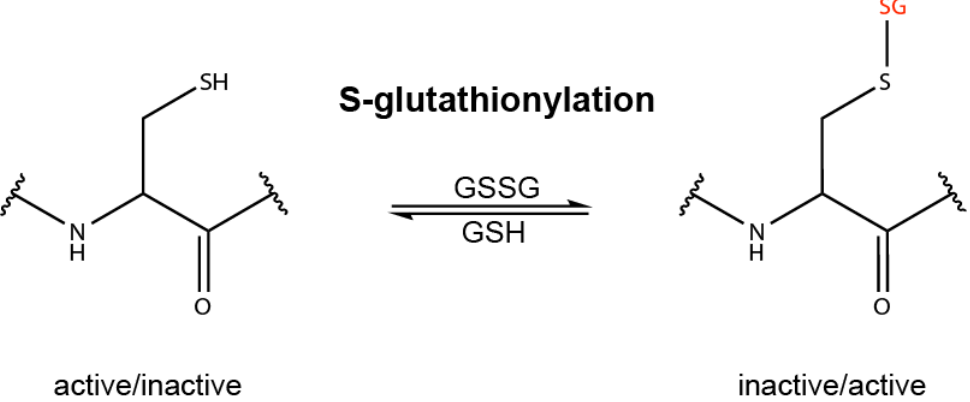
Figure 1. Redox regulation by oxidation of redox sensitive cysteine residues. The thiol group (SH) of specific cysteine residues of proteins can be oxidized by oxidized glutathione (GSSG) or other molecules, including cysteine-reactive electrophiles, causing S-glutathionylation or other types of cysteine oxidation, such as intermolecular disulfide bond formation. These types of post-translational modifications can influence the properties of proteins and the activity of enzymes, which is termed redox regulation or redox signaling.